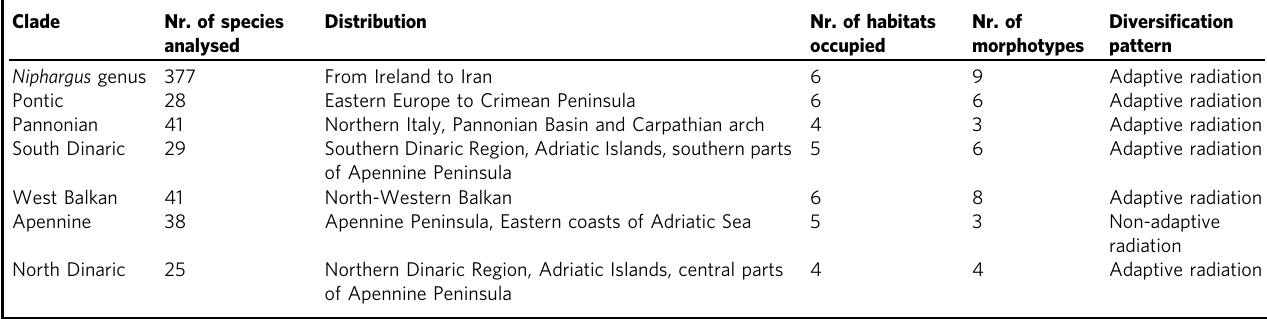
Table 3 Summary of diversi fi cation patterns of the genus Niphargus and its major subclades. Clade